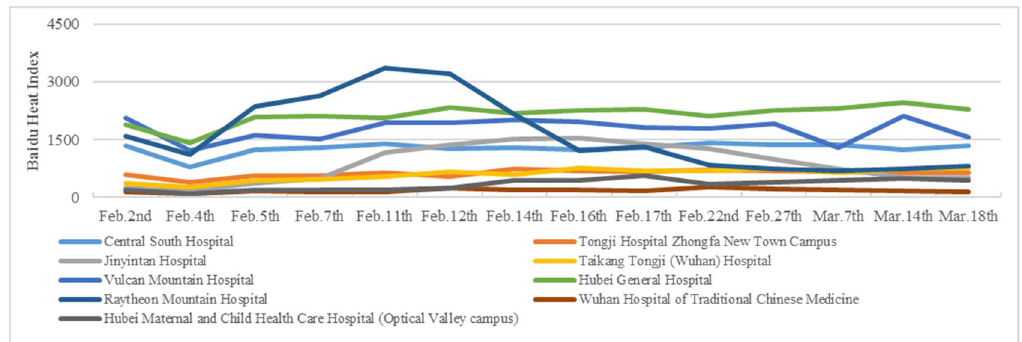
Figure 15. The changes of the population heat values in designated hospitals.